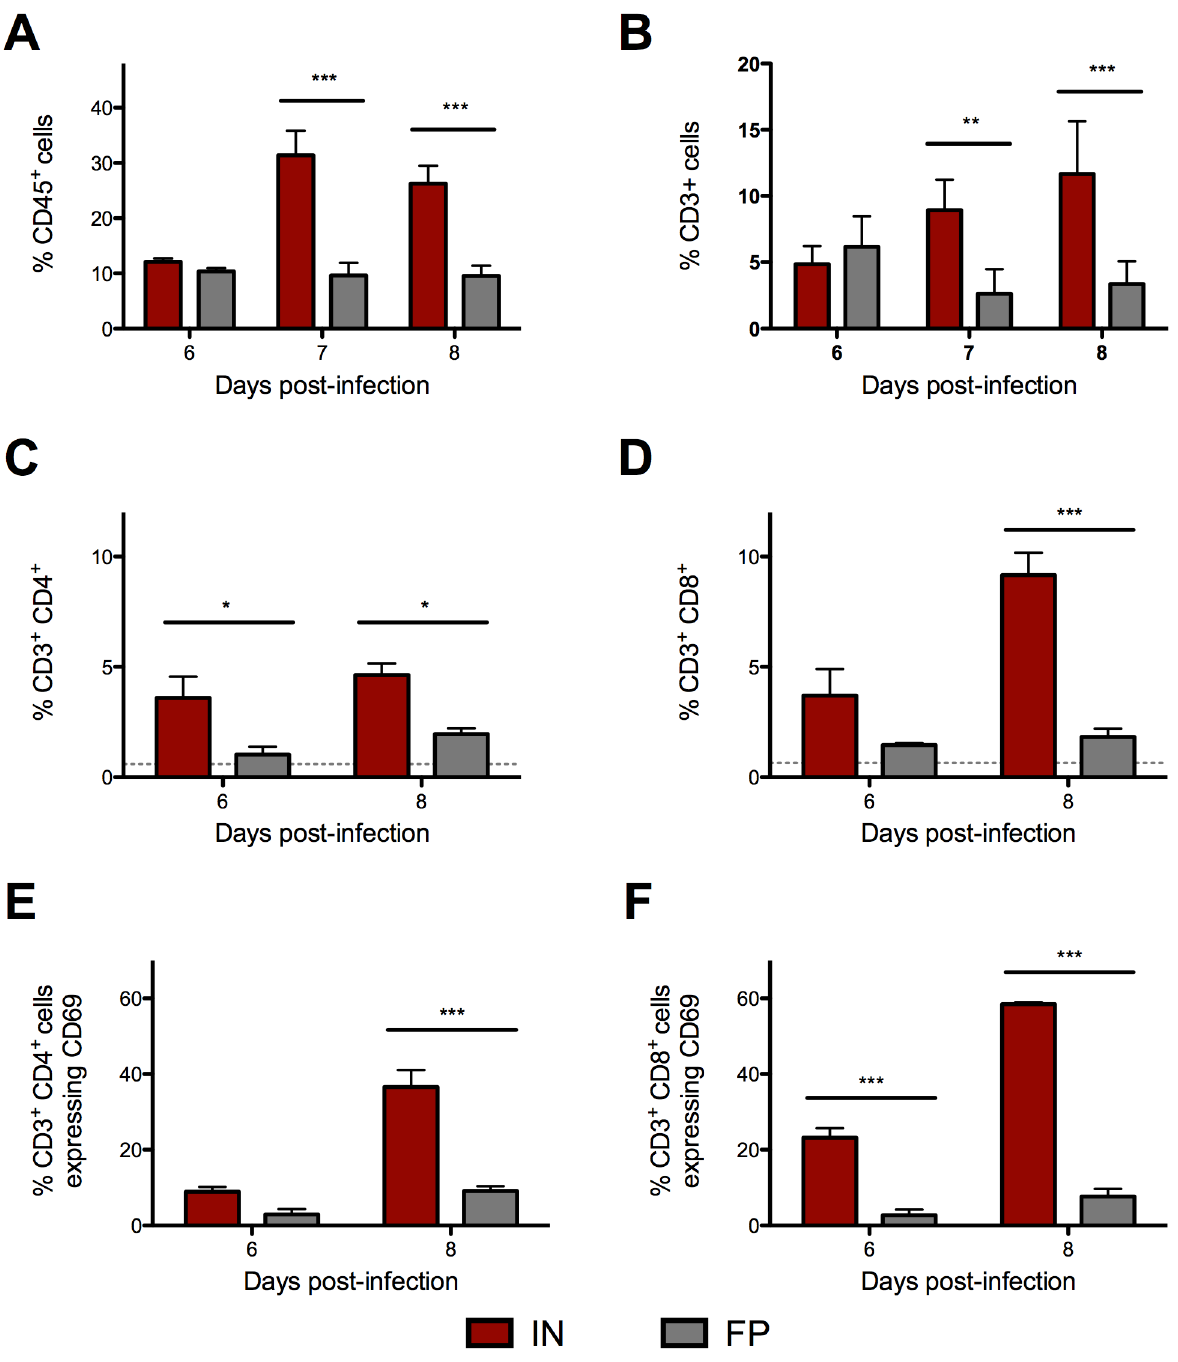
Figure 7. More activated CD69 + T cells infiltrated the brains of IN- than FP-inoculated mice. Leukocytes were isolated from the brains of IN- and FP-inoculated mice. In an initial experiment, of the proportion of (A) CD45 + cells that were (B) CD3 + T cells were determined. In a follow-up experiment, the proportion of (C) CD4 + and (D) CD8 + T cells in the brains of IN-inoculated mice and FP-inoculated mice were determined. The proportion of T cells that stained positive for activation marker CD69 are shown in (E) CD3 + /CD4 + /CD69 + and (F) CD3 + /CD8 + /CD69 + .Means based on groups of 3 mice per time point.